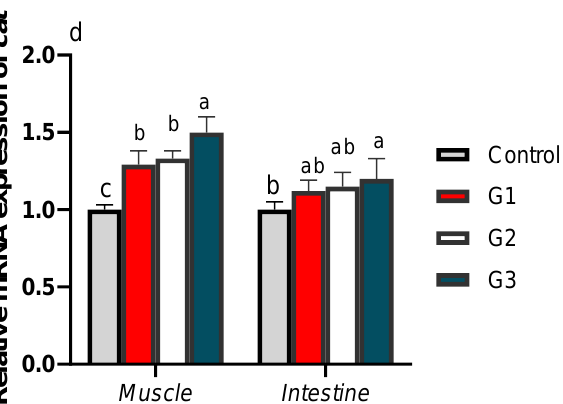
Figure 1. Transcriptional levels of digestive enzymes (lipase, α -amylase, pepsinogen and chymotrypsinogen) encoding genes ( a ) and muscle and intestinal antioxidant-related genes [ gsh-px ; glutathione peroxidase ( b ), sod ; superoxide dismutase ( c ), and cat ; catalase ( d )] in fish fed diets fortified with Thy and/or ThQ. Results are expressed as means ± SEM. Columns with various letters represent significant variations ( p < 0.05). Control: tilapia fed basal diets without any supplementations, G1: tilapia fed basal diets with thymol (Thy) supplementation at a concentration of 200 mg/kg diet, G2: tilapia fed basal diets with thymoquinone (ThQ) supplementation at a concentration of 200 mg/kg diet, and G3: tilapia fed basal diets with Thy/ThQ supplementation at a concentration of 200 mg/kg diet each.